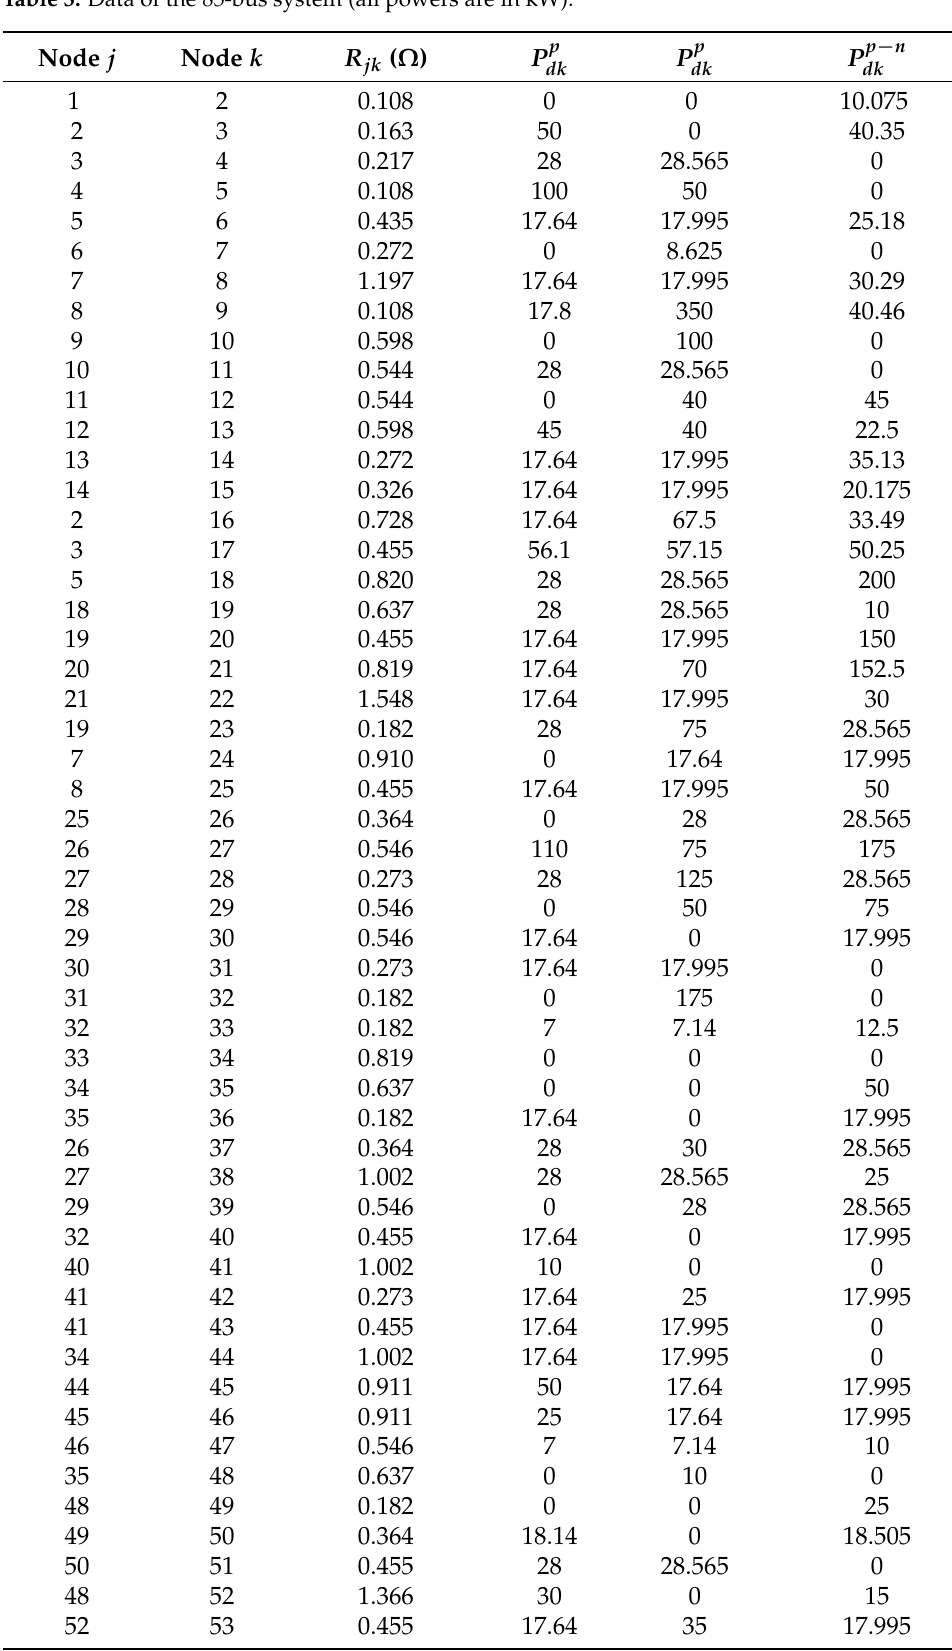
Table 3. Data of the 85-bus system (all powers are in